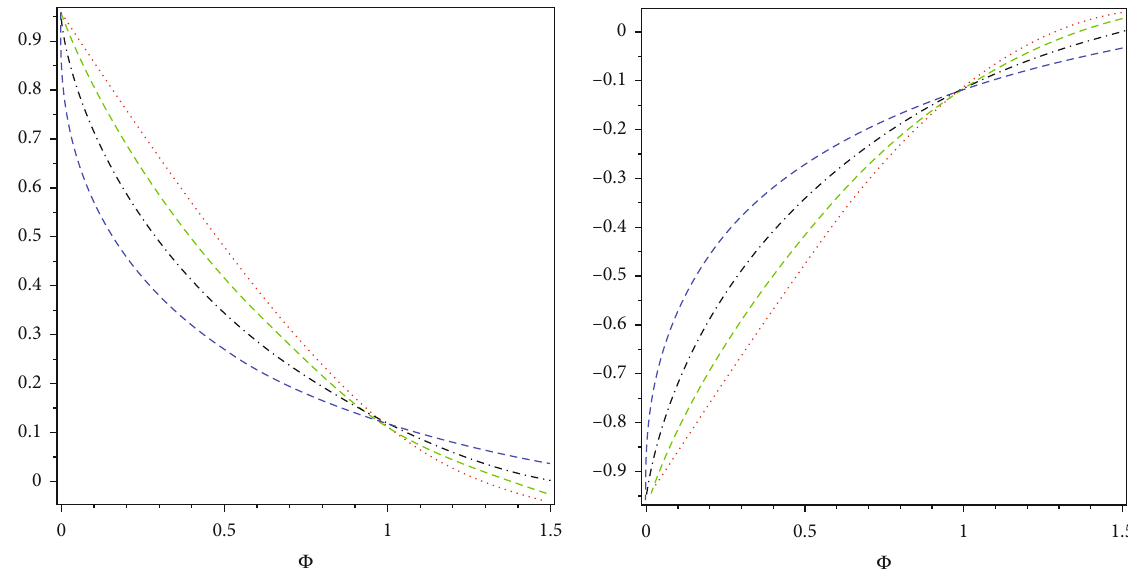
Figure 6: The fi rst graph depicts a two-dimensional fuzzy upper and bottom branch graph of an analytic series result with respect to space and